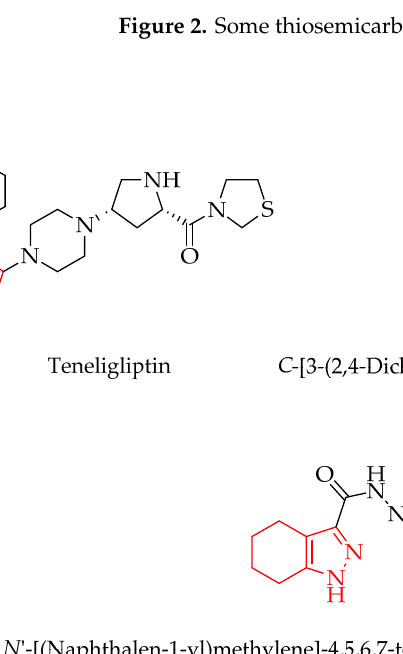
Figure 3. Some pyrazole derivatives as DPP-4 inhibitors.